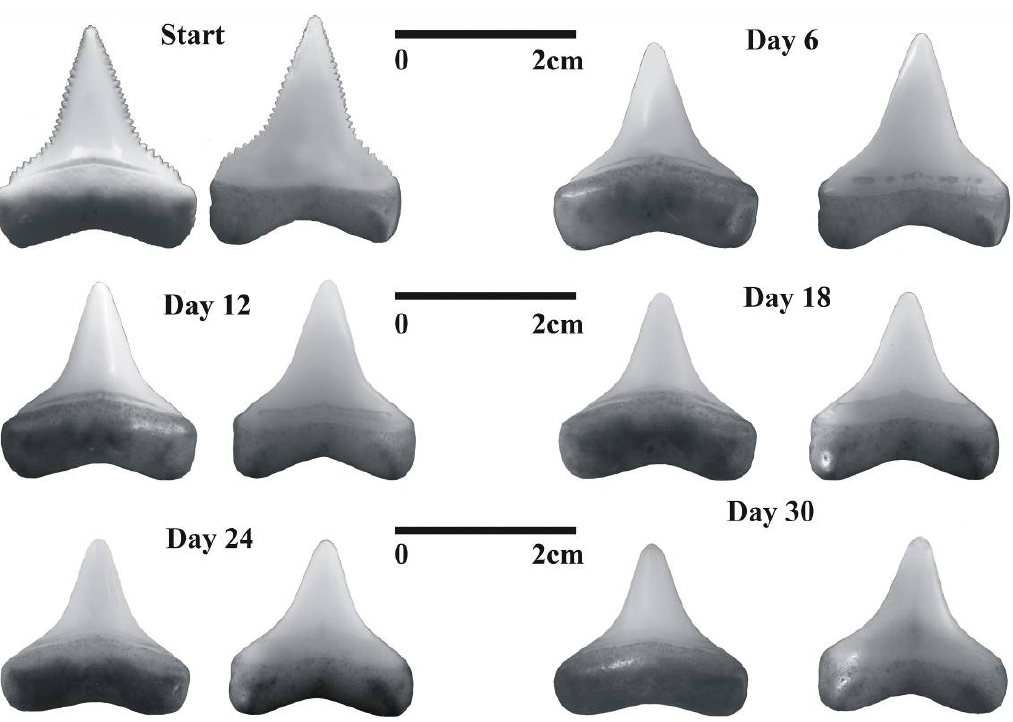
Figure 6. Carcharodon carcharias functional tooth (lingual and labial views) during one month in an industrial tumbler with 5.0 kg of host sediment from the lowermost Navesink Formation. Individual teeth were removed at six day intervals and photographed. All scale bars = 2.0 cm. Note iron staining in root and along cusp edges, and physical changes similar to those seen in Figures 5 and